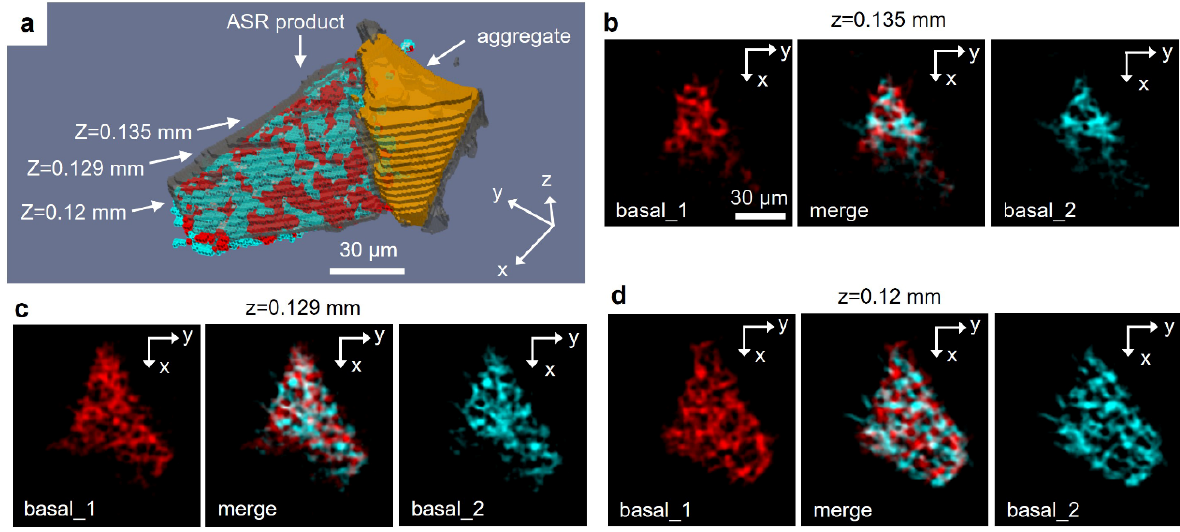
Figure 9. (a) Reconstructed distribution of basal_1 and basal_2 in the ASR product vein at RH ~ 10% in 3D view and (b ‐ d) planar view at various vertical locations. The scale bar in b also applies to c and d (adapted from